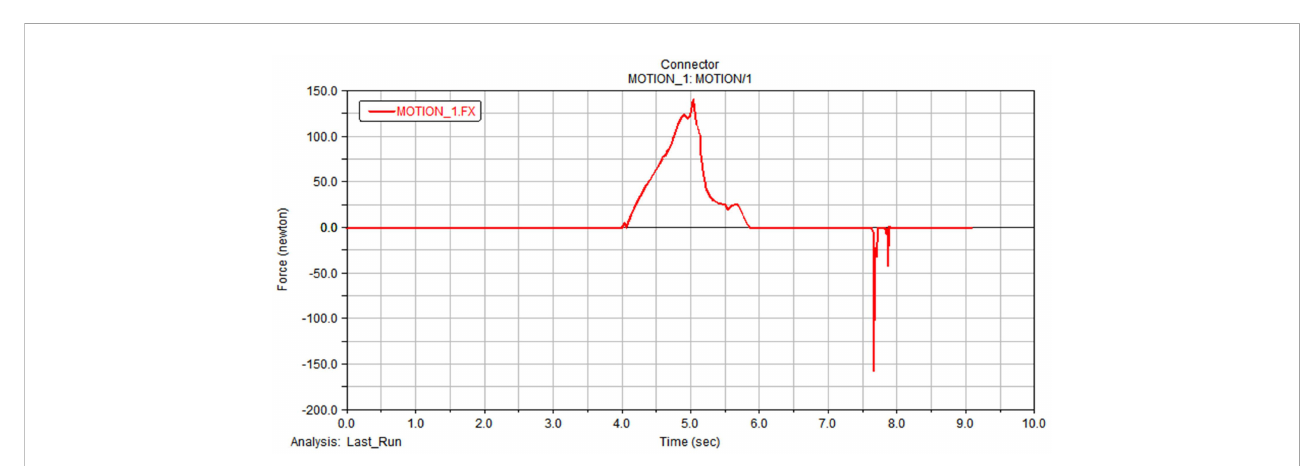
FIGURE 9 Force curve during